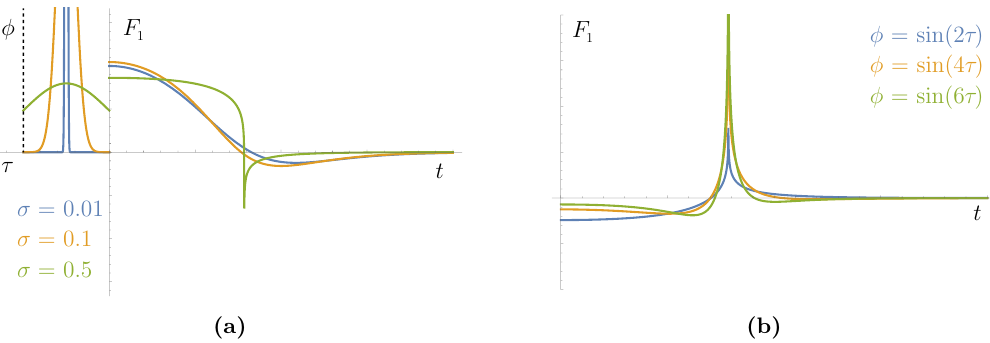
Figure 8. We plot F 1 for some relevant sources profiles for the BTZ scenario. In (a) we take Gaussians of different width shown to the left and plot F in the positive axis. We consider the 1 limit in which the source is a Dirac delta σ → 0 . The limit can be seen to be finite. One should regard the negative piece of the horizontal axis as τ and the positive piece as t . Notice that there is only a finite domain for r [ − π/ 2 , 0] and that if the Gaussian is too fat, φ (0) 6 = 0 and the s τ ∈ system responds with divergences in finite time. In (b) we different single frequency modes as sources. Despite meeting φ (0) = 0 these modes not only do not produce single mode responses, which matches expectation, but also produce divergences at finite time in the response